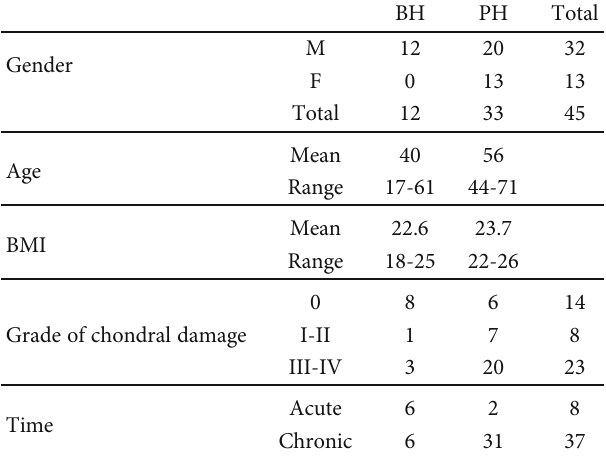
Figure 1: Modi fi cations of cytokine levels in relation to the type of lesion. Cytokine concentrations measured in the population with medial meniscal tears ( n = 45 ) that are signi fi cantly in fl uenced by the type of lesion are represented in the box plots. In each plot, the box is built within the third (upper bound) and fi rst (lower bound) quartiles (i.e., Q3, Q1); the middle line represents the median. Whiskers represent data maximum (upper whisker) and minimum (lower whisker). + indicates data outliers, de fi ned as − Q1 Þ